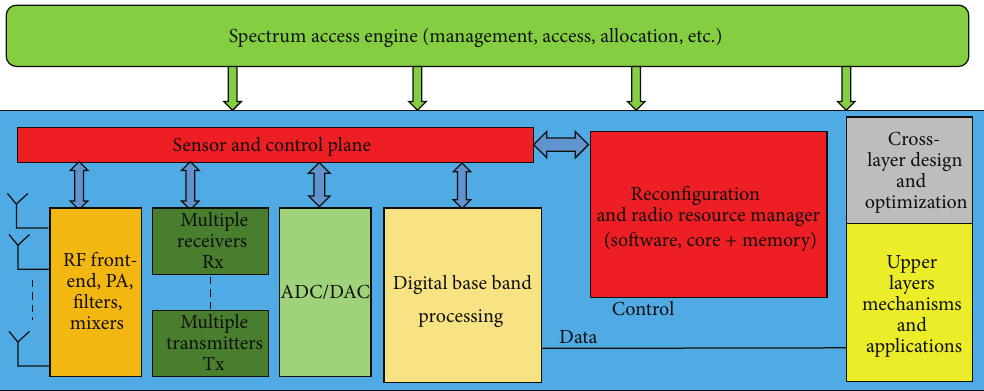
Spectrum access engine (management, access, allocation, etc.)